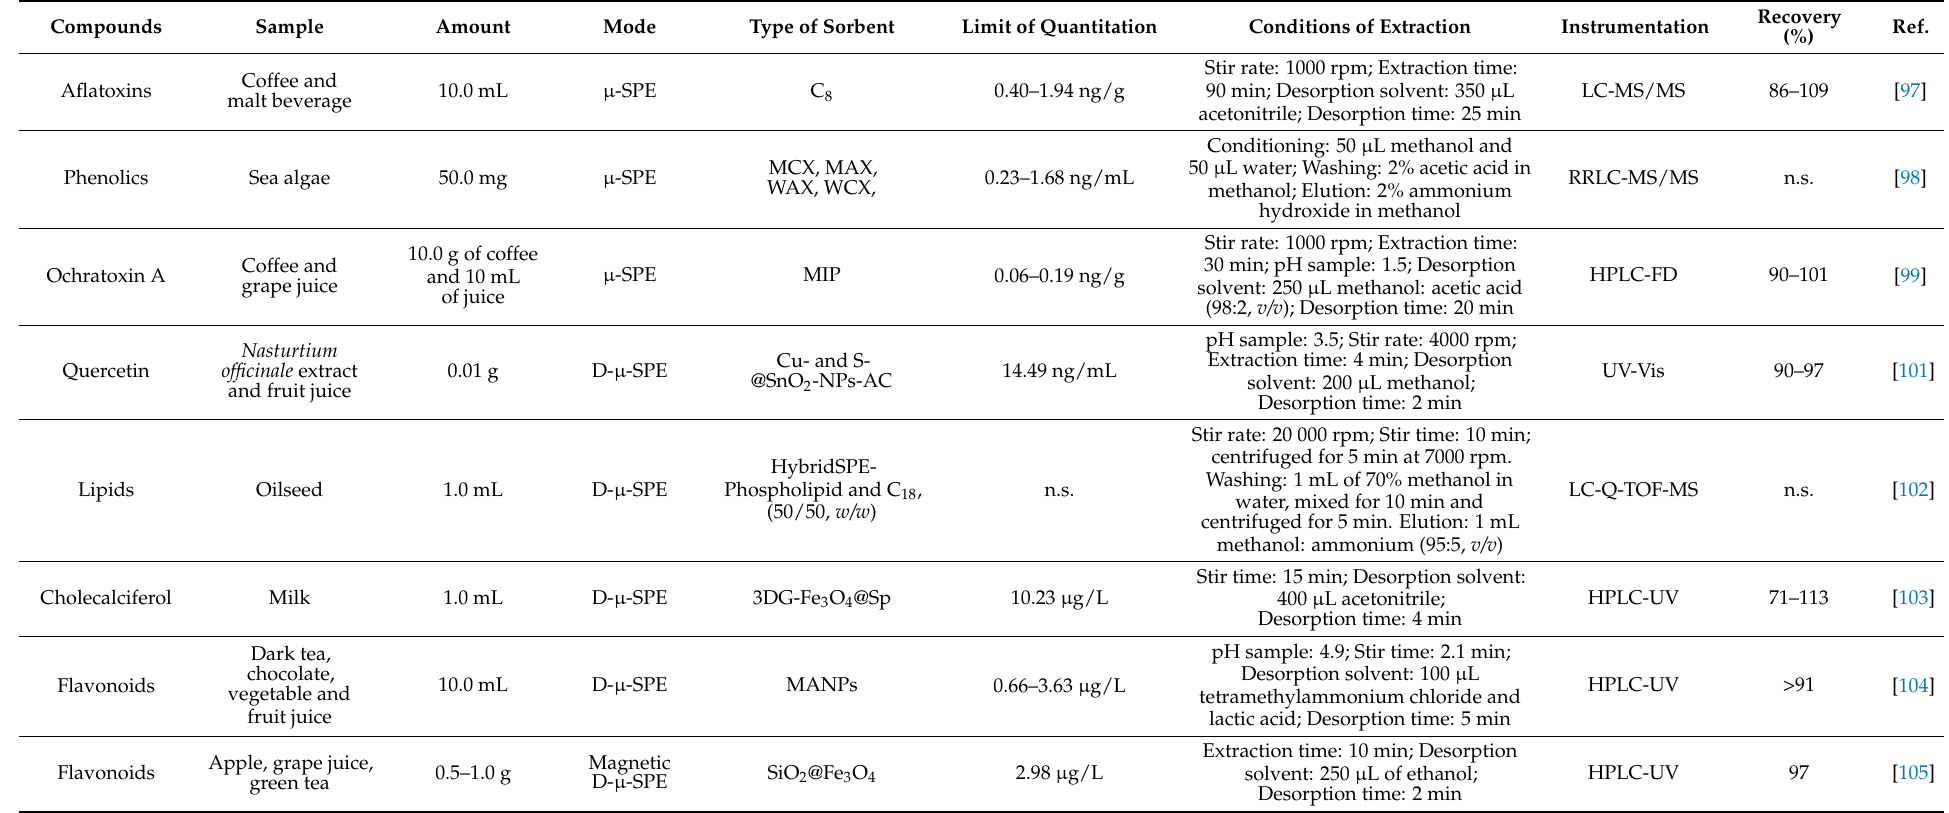
Table 6. Application of µ -SPE/D- µ -SPE techniques for extraction of several compounds in natural